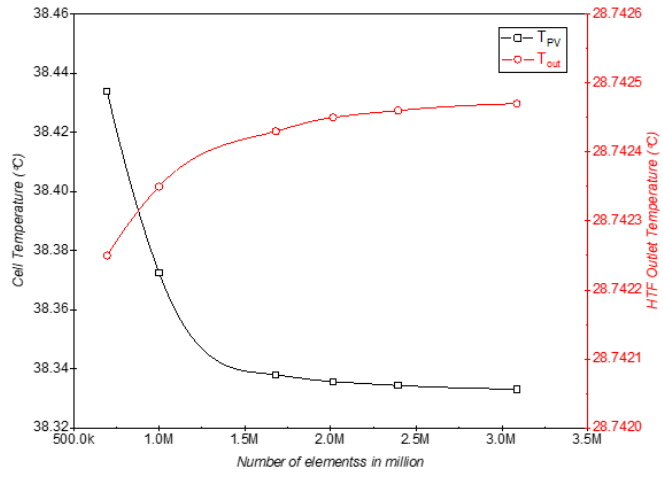
Figure 8. Mesh independence study for solar cell temperature, and HTF outlet temperature.